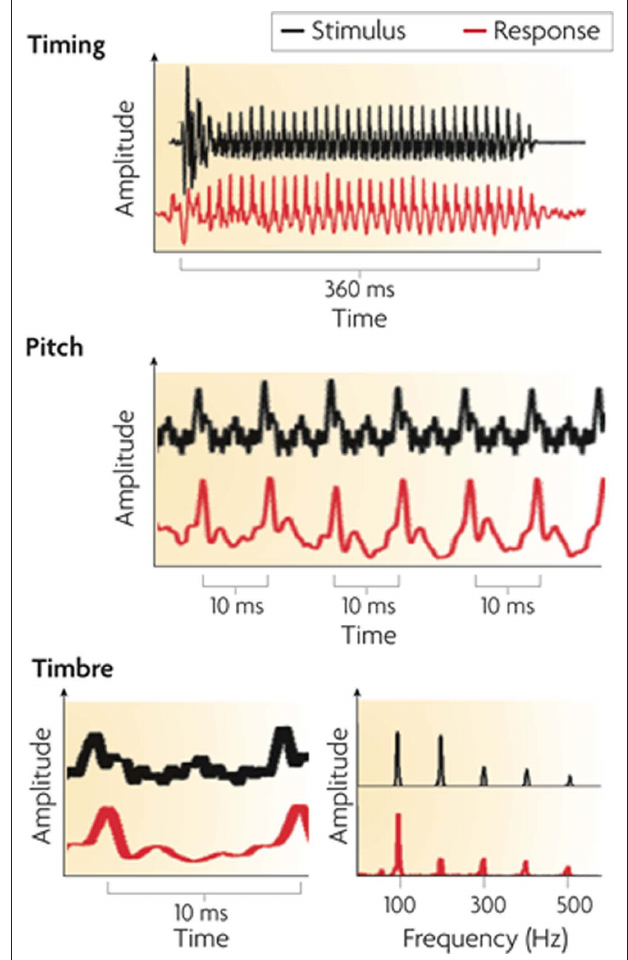
FiguRE 3 | The auditory brainstem response to the spoken syllable /da/ (red) in comparison to the acoustic waveform of the syllable (black). The neural response can be studied in the time domain as changes in amplitude across time (top, middle and bottom-left panels) and in the spectral domain as spectral amplitudes across frequency (bottom-right panel). The auditory brainstem response reflects acoustic landmarks in the speech signal with submillisecond precision in timing and phase locking that corresponds to (and physically resembles) pitch and timbre information in the stimulus. From Kraus and Chandrasekaran (2010), reproduced